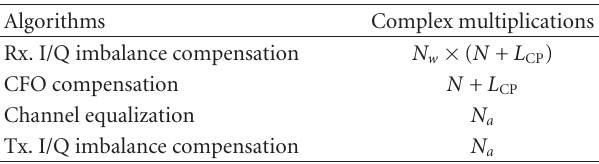
Table 1: Computational complexities per OFDM symbol for di ff erent compensation stages.